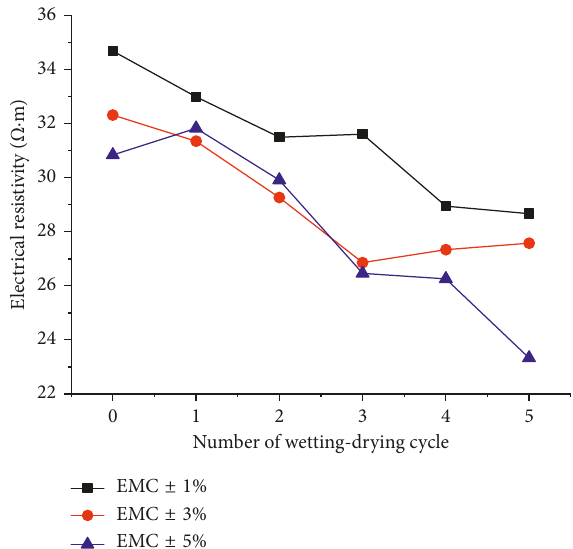
Figure 12: Variations of final electrical resistivity with wetting- drying